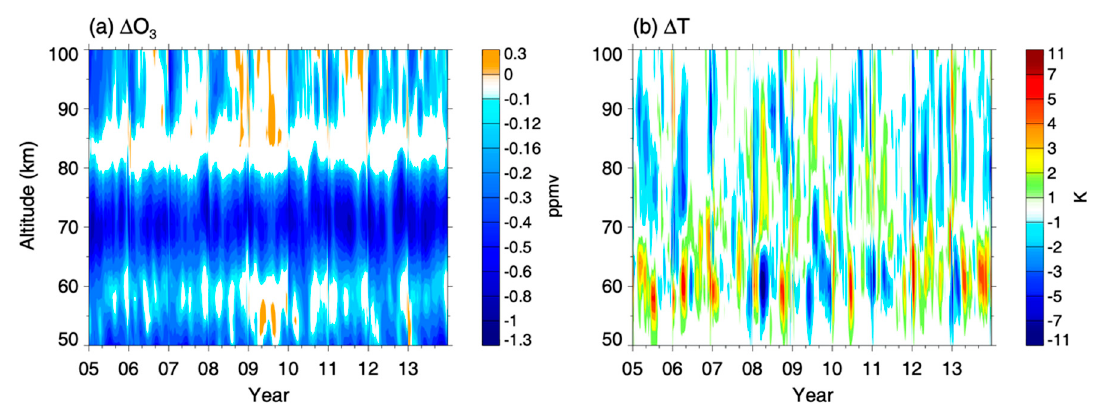
Figure 10. The height profiles of the differences (MEE-Control) in the zonal mean ozone and temperature averaged over the latitude range of 70° S–90° S are presented in the altitude range of 50–100 km during southern winter (June, July and August) for the entire study period from 2005 to 2013. The 10-day moving average was applied.